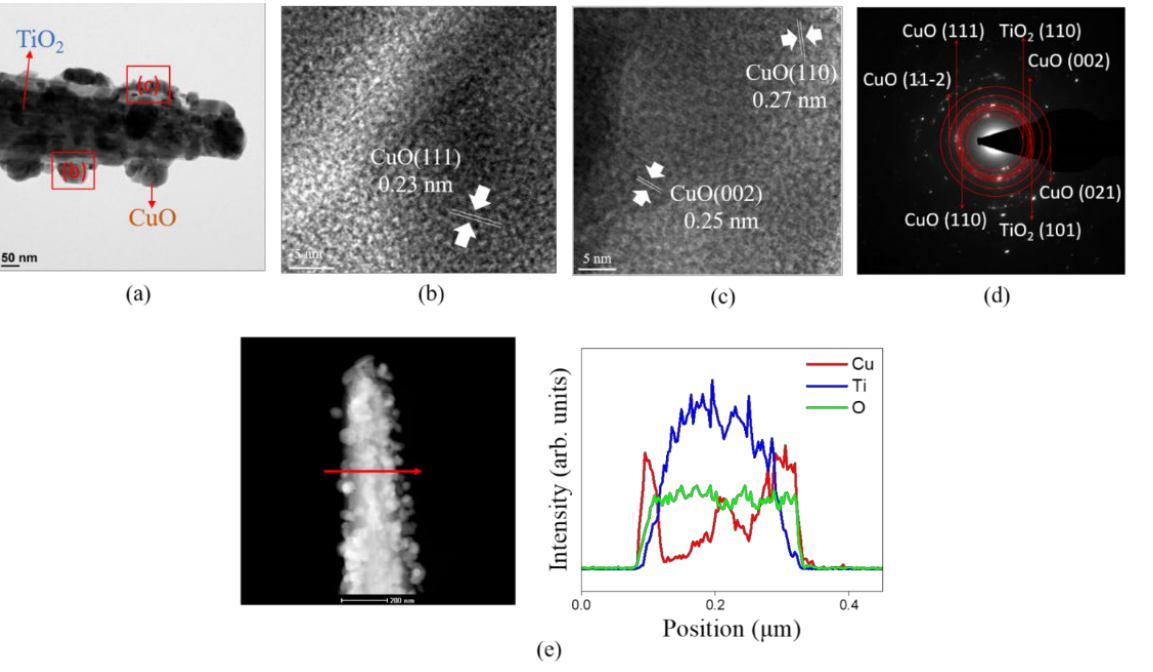
Figure 5. TEM analysis of TC400: ( a ) low-magnification TEM image; ( b , c ) HRTEM images of various regions of the composite rod as marked in ( a ); ( d ) SAED patterns of several TC400 nanorods; ( e ) EDS line scanning profiles across the composite rod.